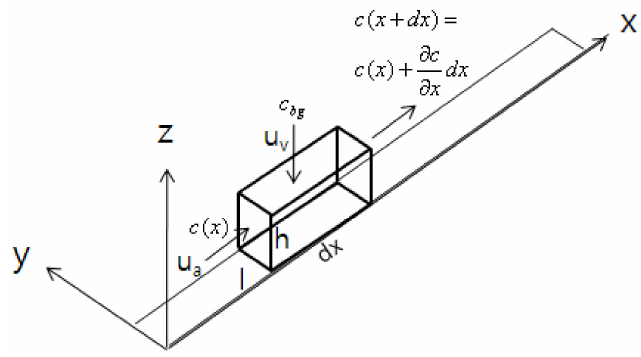
Figure 1. Schematic of the control volume in a